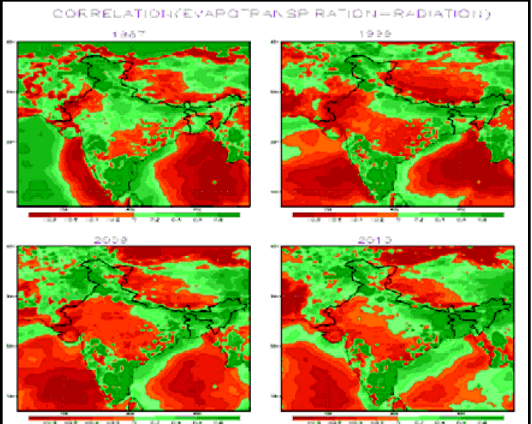
Figure 6. Correlation between evapotranspiration (mm/day) and radiation (W/m 2 ) (cid:5) (E,R n ) using BATS scheme for El Niño (1987,2009), La Niña (1999,2010) years.